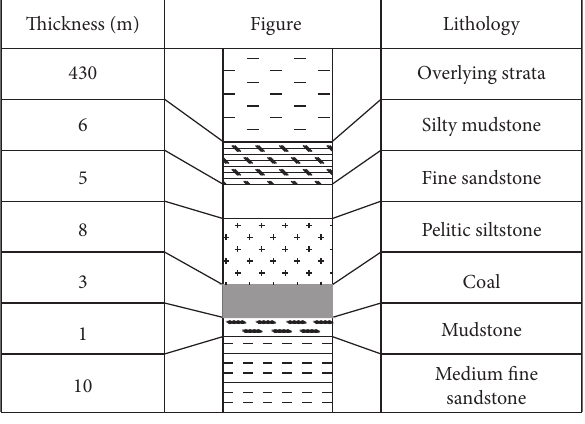
Figure 3: Generalized stratigraphy column of the test site. Table 1: Mechanical parameters of